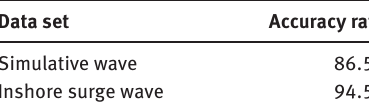
Table 1: Comparison of the accuracy rate (%) of the proposed approach on two data sets collected by the DJI drone. Data